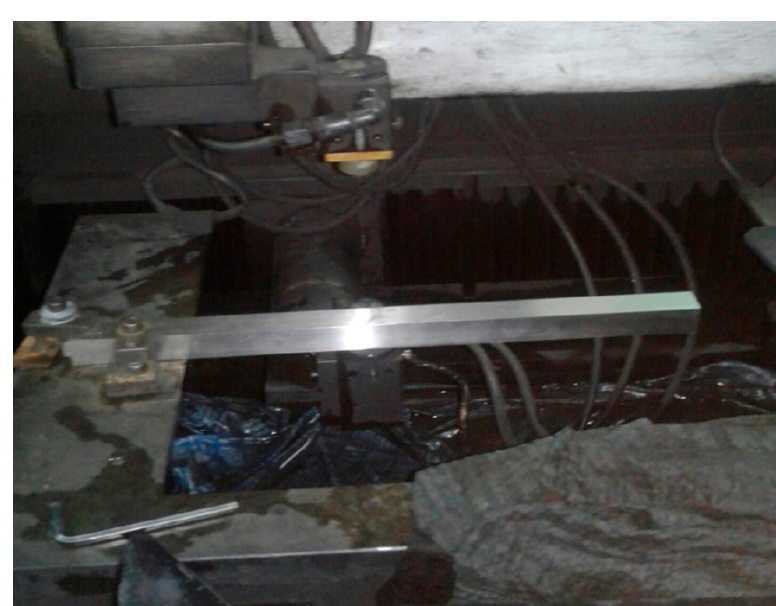
Figure 3. Experiment set up on WEDM. Table 1. Chemical characteristics of Monel K-500.